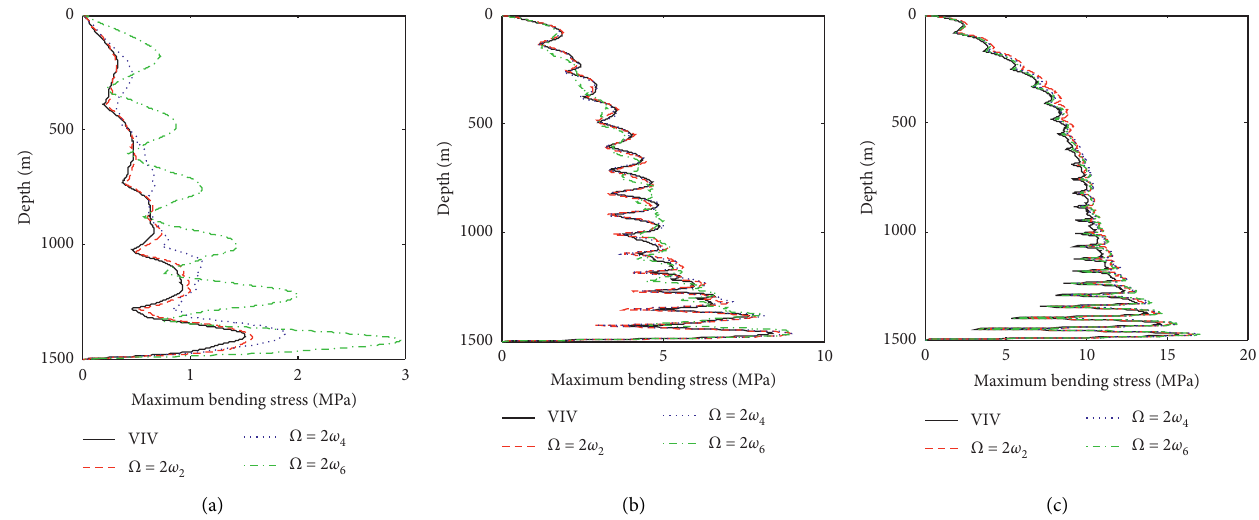
Figure 9: The maximum bending stress of TTR ( a � 1 m ): (a) U